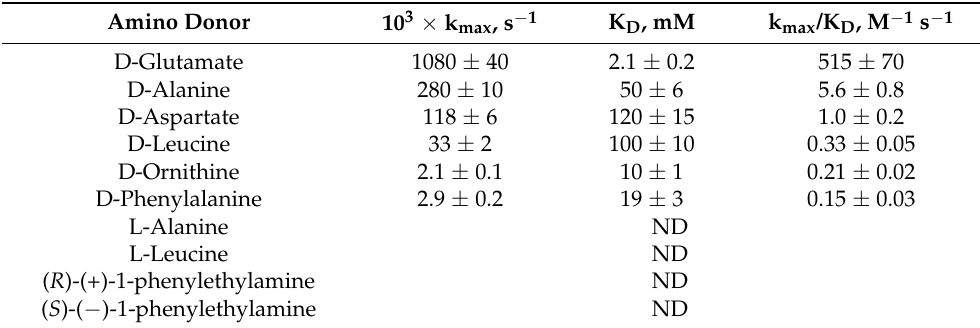
Table 3. Kinetic parameters of half-reactions between the PLP form of AmicoTA and amino donors in 50 mM CHES buffer, pH 9.0, at 40 ◦ C. ND—not detected. The values of the rate constants of the reverse reactions were zero for all